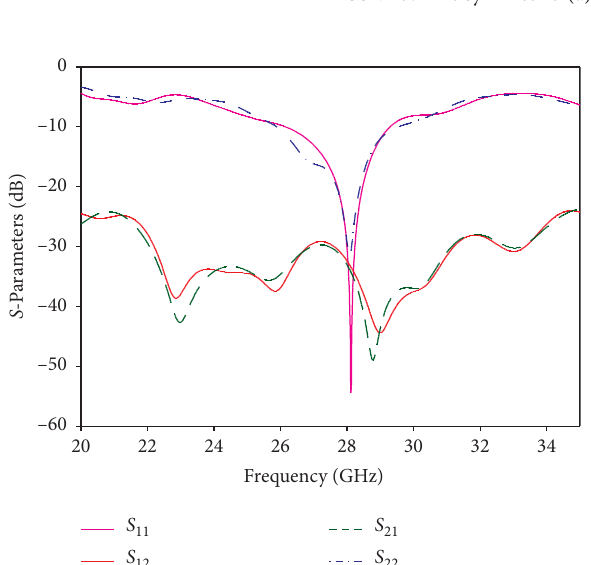
Figure 5: Antisymmetric (a) and symmetric (b) configuration.